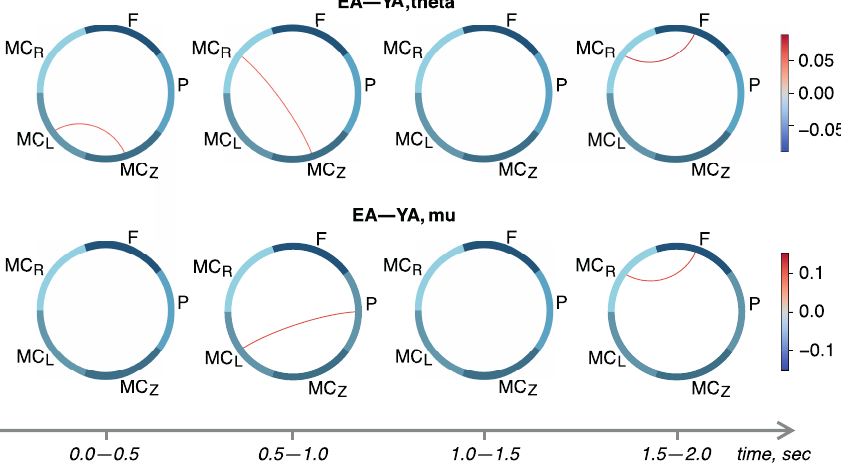
Figure 4. Between-group analysis of functional dependencies established by proposed FF-MLP model in the theta- ( upper row) and mu-range ( lower